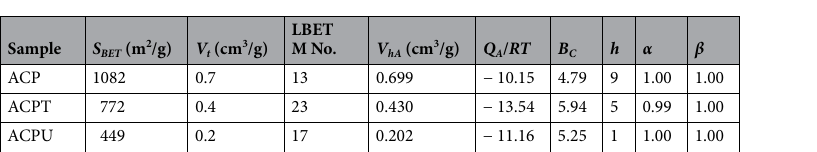
Table 3. Parameters characterizing the microporous structure of the activated carbons obtained by phosphoric acid activation (ACP) and subjected to thermal (ACPT) and chemical (ACPU) post-treatments, based on the analysis of N 2 adsorption isotherms using the BET, LBET, and QSDFT methods.